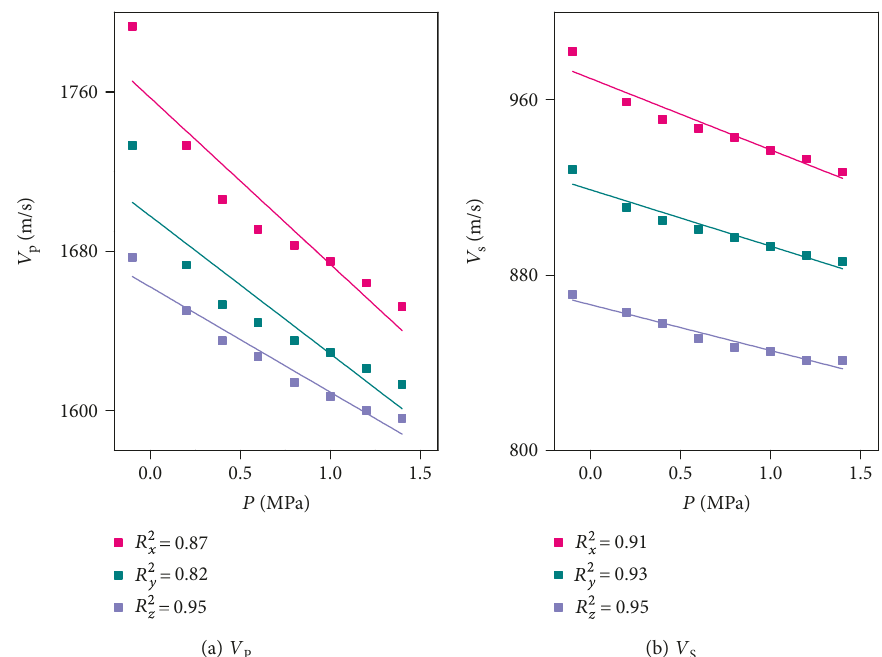
Figure 5: Characteristic charts of ultrasonic velocity of coal samples at di ff erent gas pressures.